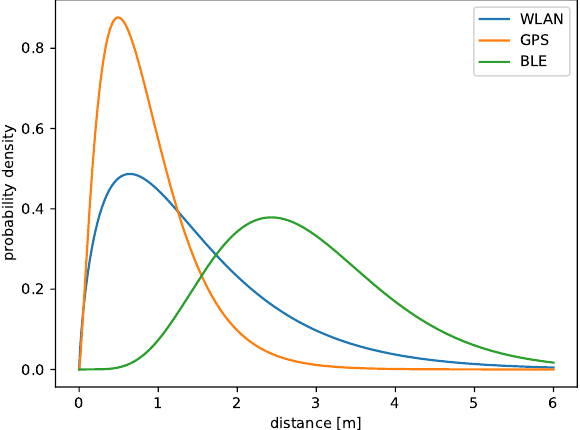
Figure 5. Gamma distributions corresponding to localization methods used in